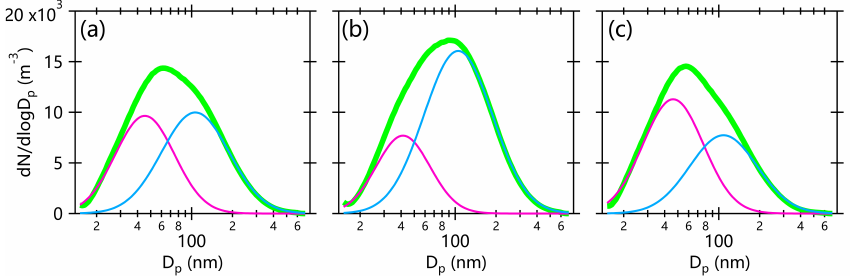
Figure 8. Average particle number size distributions during (a) the entire study, (b) polluted events, and (c) clean periods.